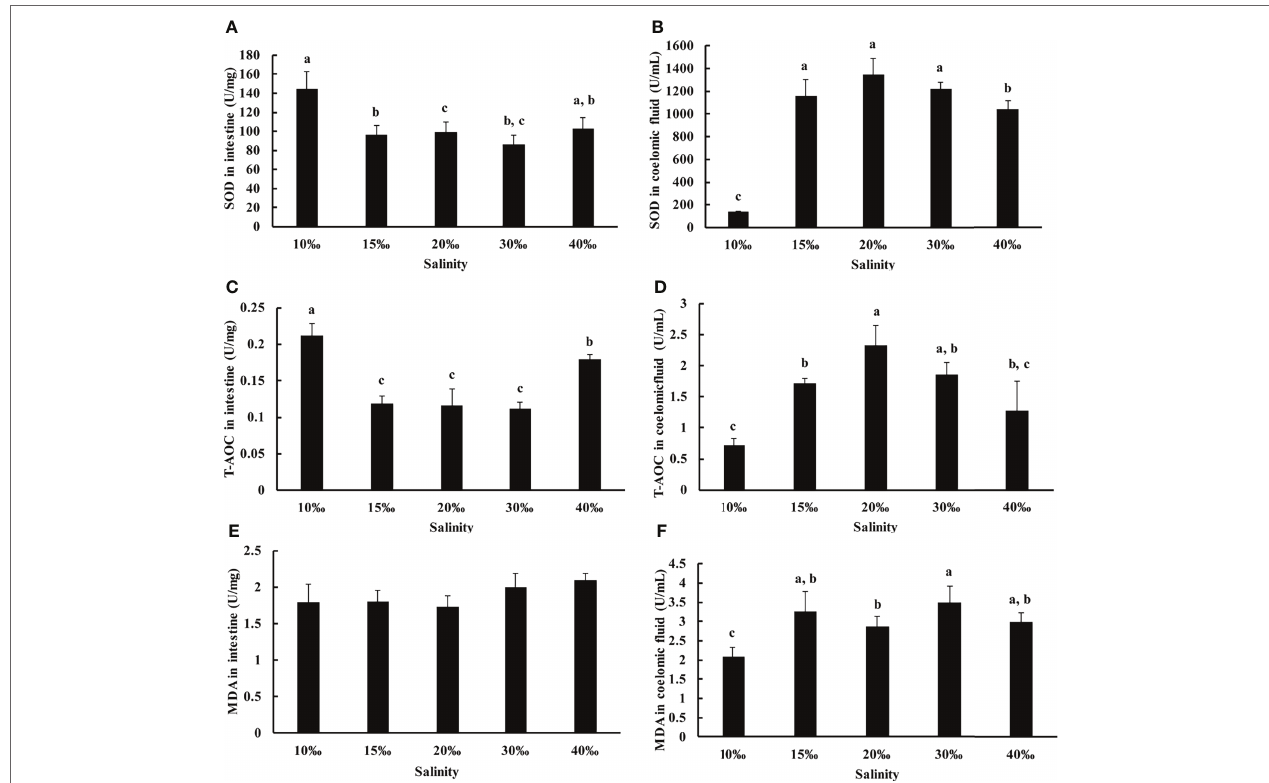
FIGURE 2 | Oxidative stress related indices in the intestine and coelomic fluid of U. unicinctus juvenile reared in different salinities for 8 weeks. Superoxide dismutase (SOD, A , B ), total antioxidant capacity (T-AOC, C , D ) and malondialdehyde (MDA, E , F ). The data are mean values of three replicates + SD (n = 3). Different letters indicate significant differences at different salinity (ANOVA, Tukey’s test; P <